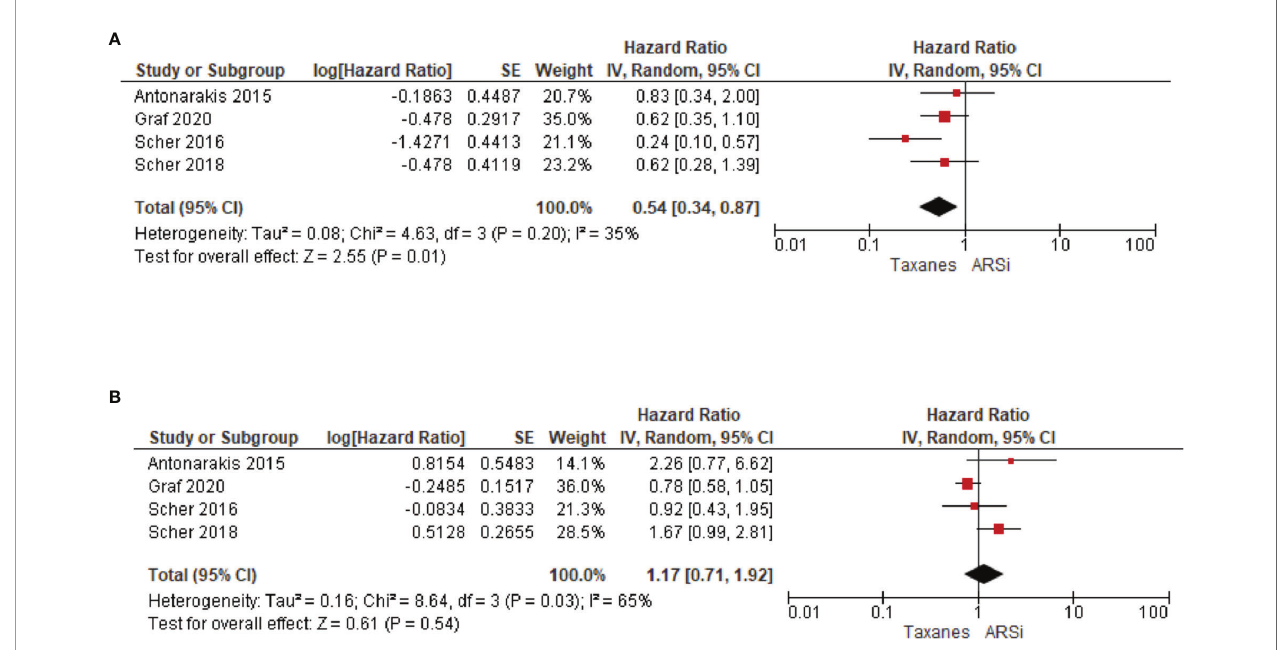
FIGURE 5 | Forest plots for association of liquid biopsy AR-V7 status with OS in (A) AR-V7 positive (ARSi vs. Chemotherapy) and (B) AR-V7 negative patients (ARSi vs. Chemotherapy). Pooled HRs were calculated using random effect model. AR-V7, androgen receptor splice variant 7; CI, con fi dence interval and bars indicate 95%